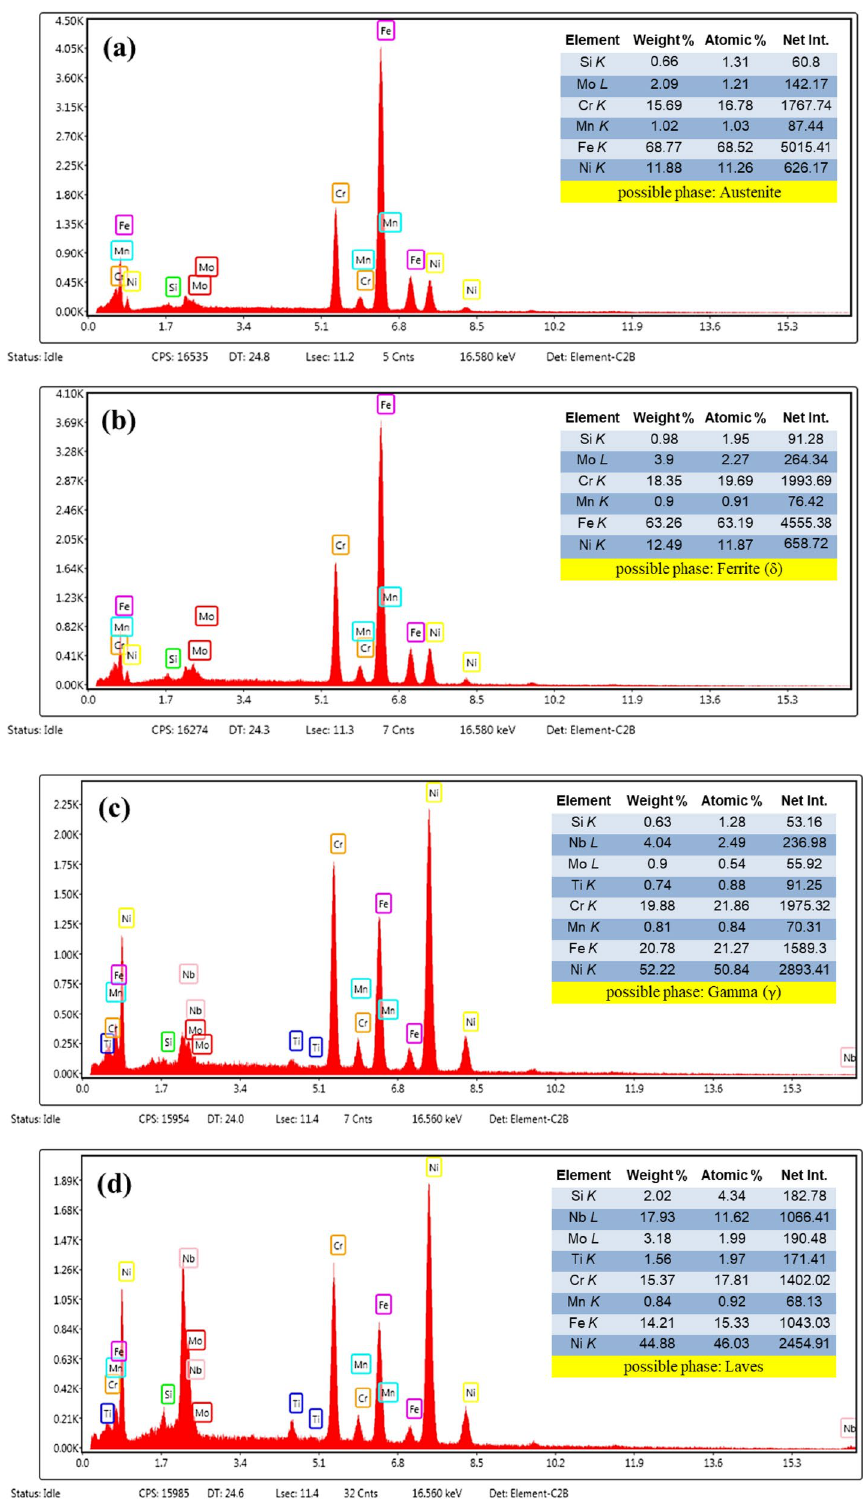
Figure 15. The results of chemical analysis and possible phases from the tip position the of arrows ( a ) 1 and ( b ) 2 in Fig. 12c and arrows ( c ) 3 and ( d ) 4 in Fig.